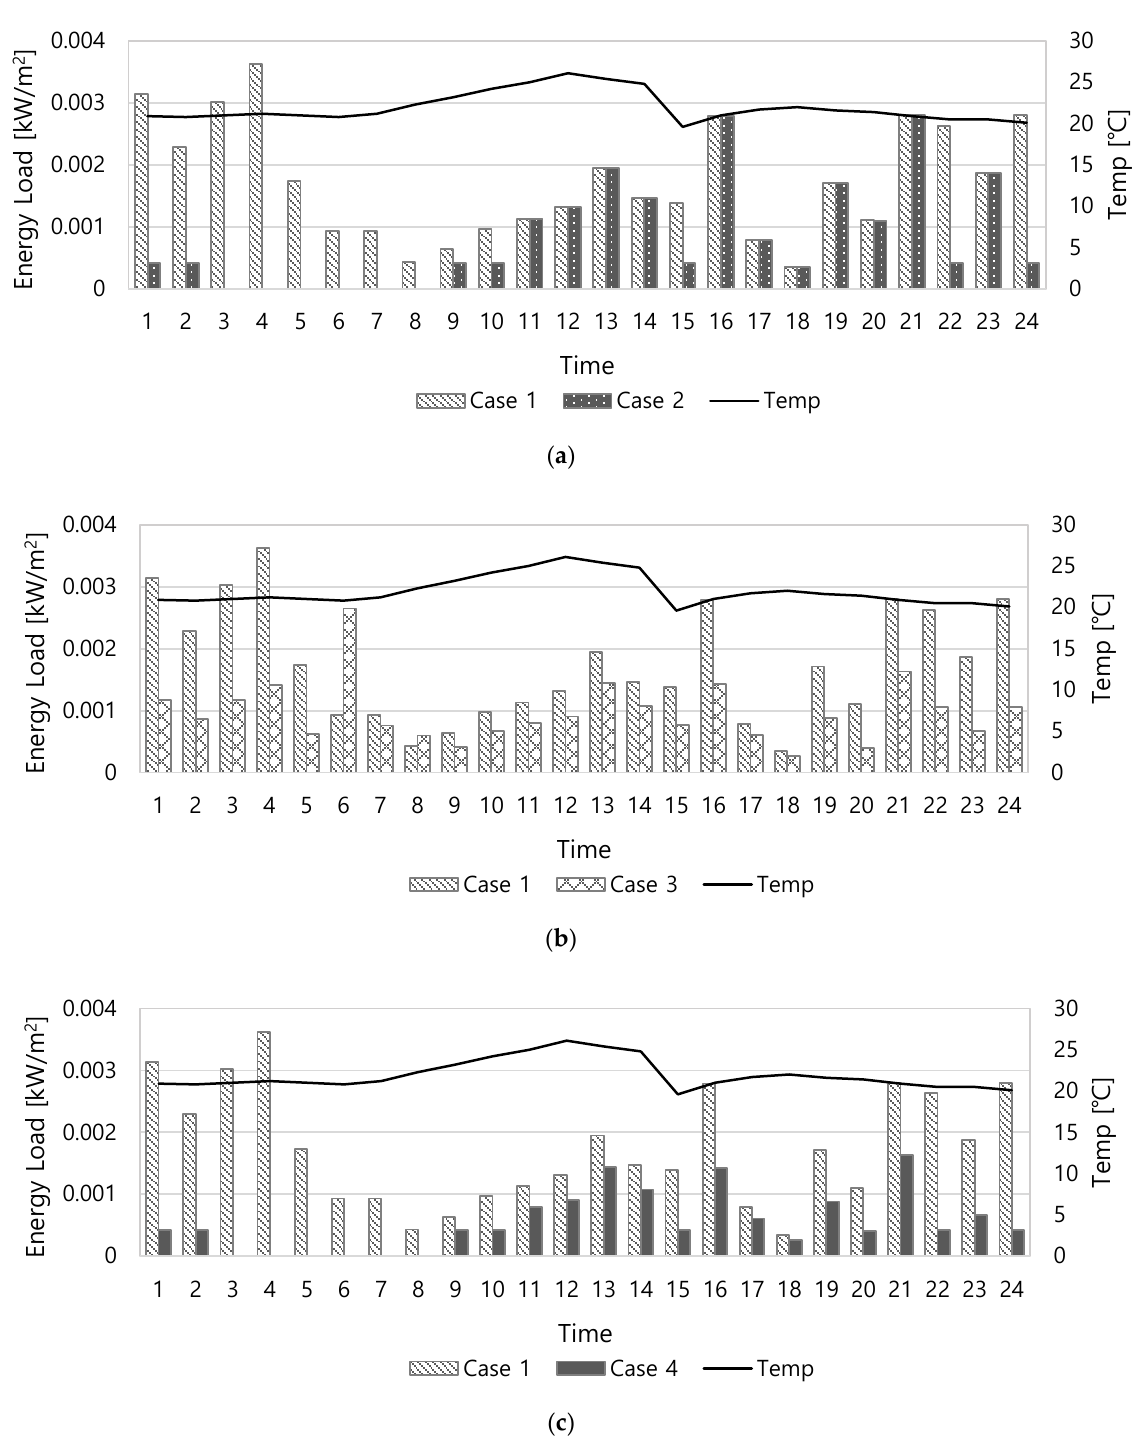
Figure 7. ( a ) Energy pattern comparison of Case 1 with Case 2. ( b ) Energy pattern comparison of Case 1 with Case 3. ( c ) Energy pattern comparison of Case 1 with Case 4.